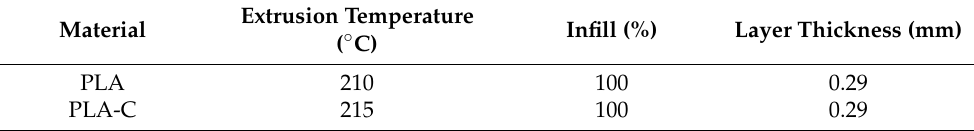
Table 1. The 3D printing parameters and weights of printed samples.